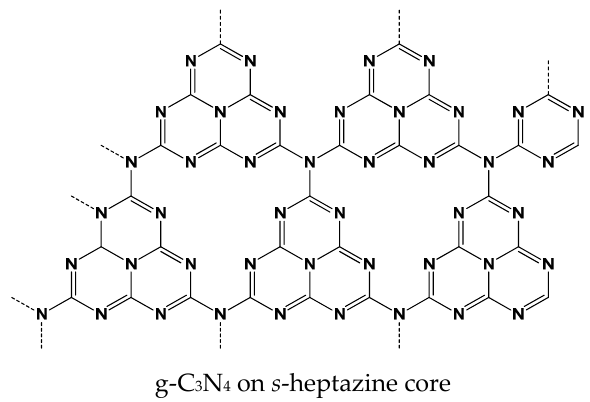
Figure 3. Idealized structure of graphitized carbon nitride (g-C 3 N 4 ).